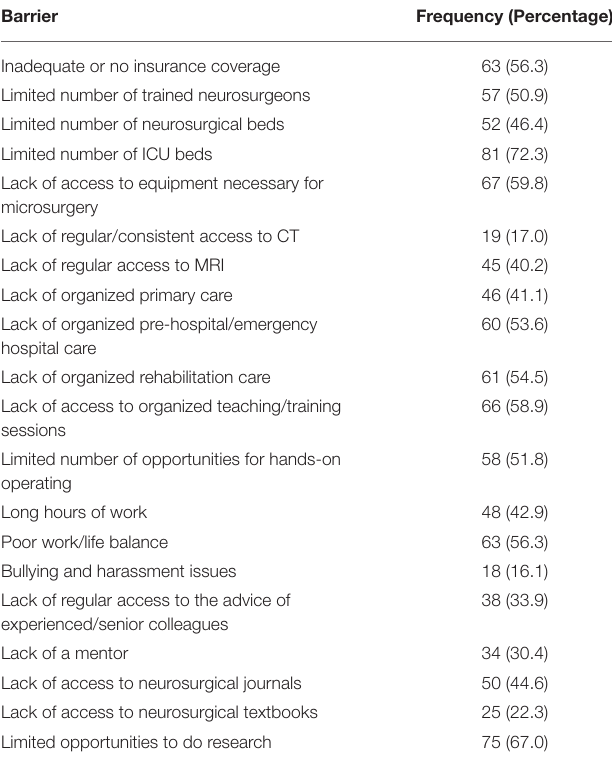
TABLE 3 | Perceived barriers to day-to-day